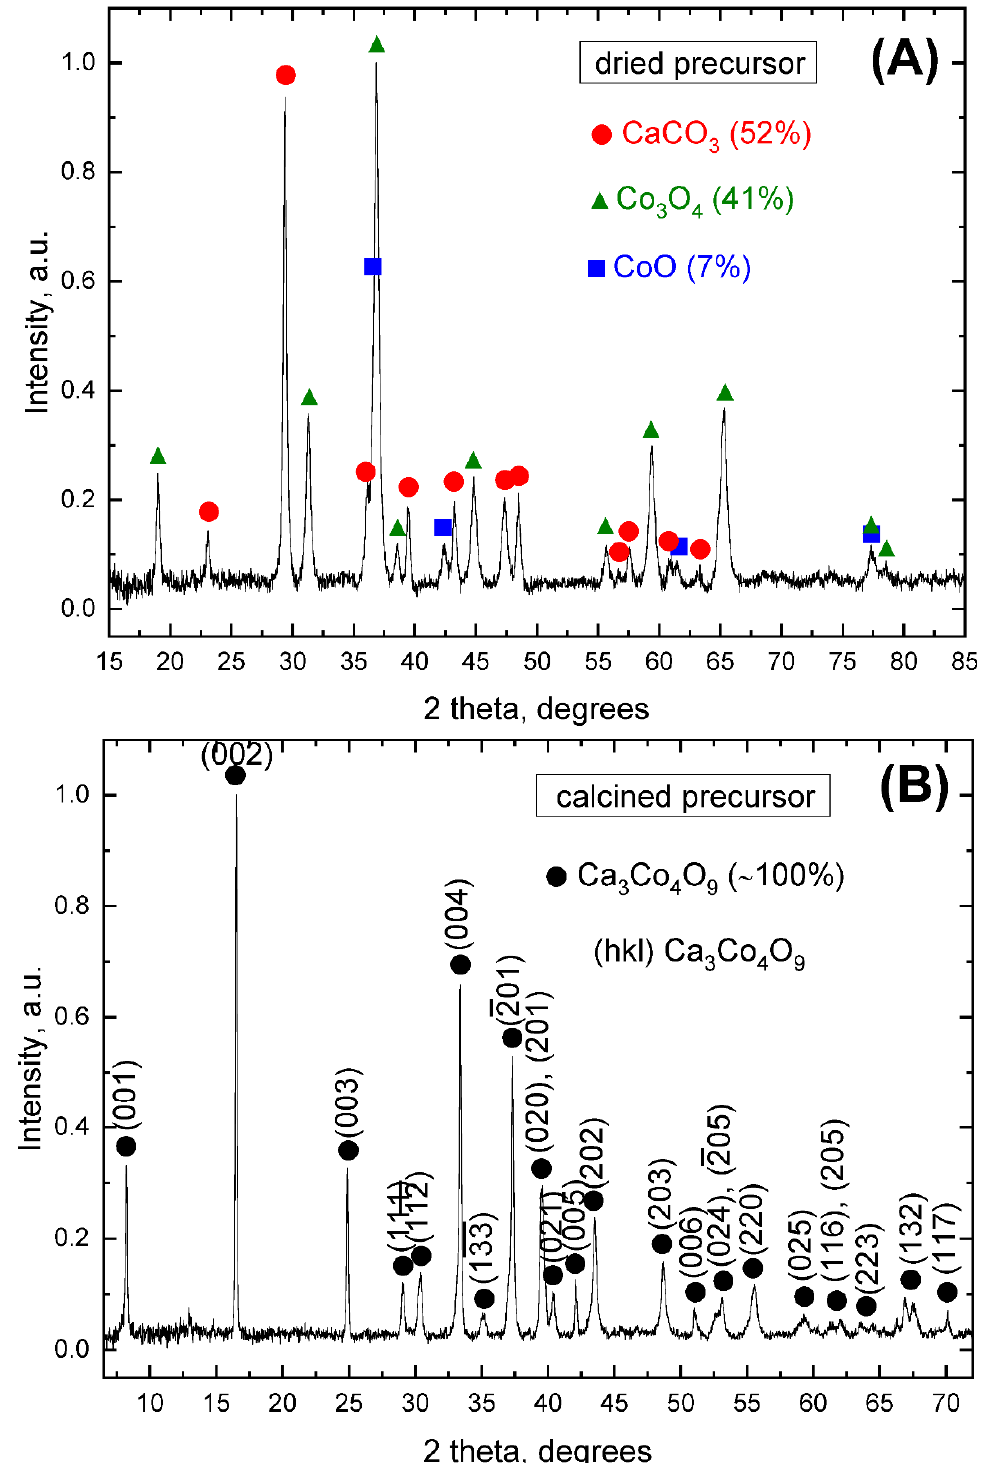
Figure 1. Normalized XRD patterns of the modified Pechini precursor powder: ( A ) after drying at ~623 K for ~3 h (organic phases burn-out) and ( B ) after the three-step thermal treatment at 573 K, 873 K (6 h) and 1023 K (6 h), showing the phase composition and estimated amount in each case. The (hkl) crystallographic planes belonging to the Ca 3 Co 4 O 9 phase are also shown in ( B ).